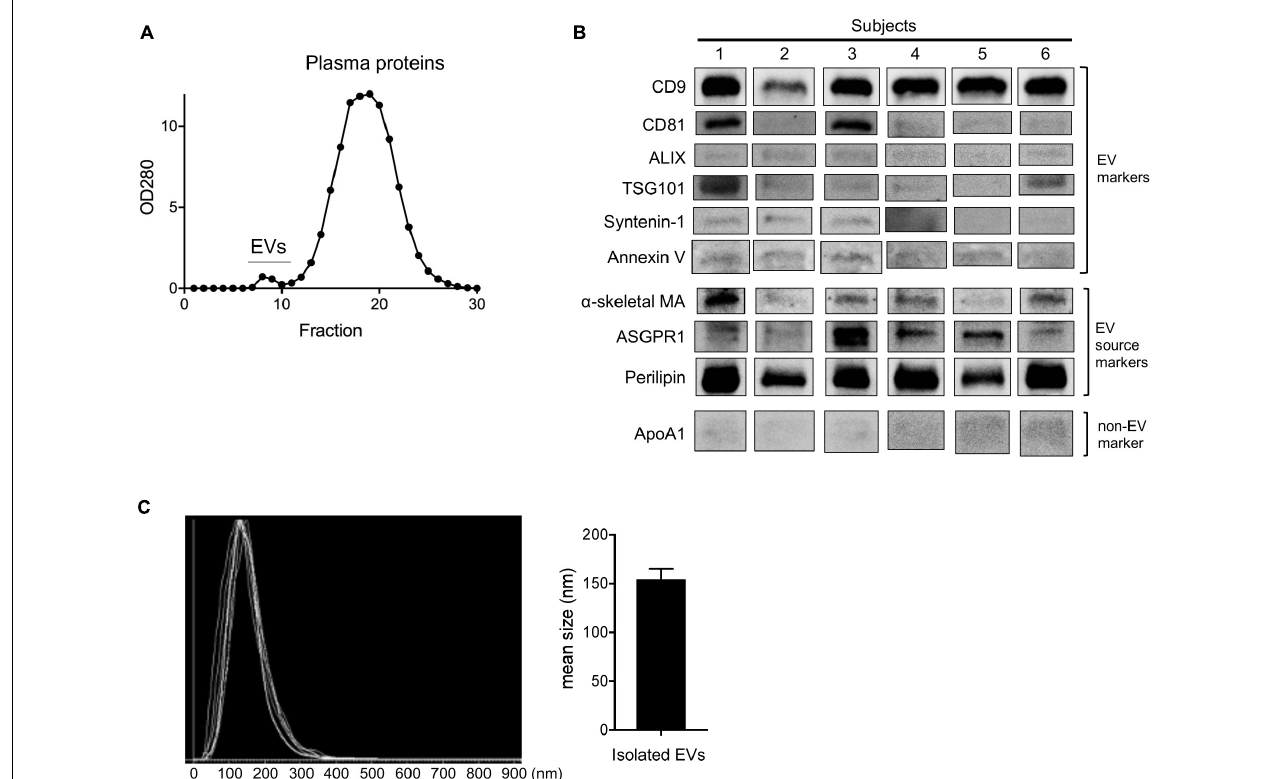
FIGURE 3 | Purification and detection of EV source from circulating EV at T 0 . (A) Purification of circulating EVs using qEV column. (B) Representative immunoblotting analysis of CD9, CD81, ALIX, TSG101, syntenin-1, annexin V, α -skeletal muscle actin ( α -skeletal MA), asialoglycoprotein receptor 1 (ASGPR1), perilipin, and apolipoprotein A1 (ApoA1) in isolated EVs from six subjects. (C) EV size of isolated EVs from six subjects by nano tracking analysis (NTA). Bar graph of isolated EV size from NTA